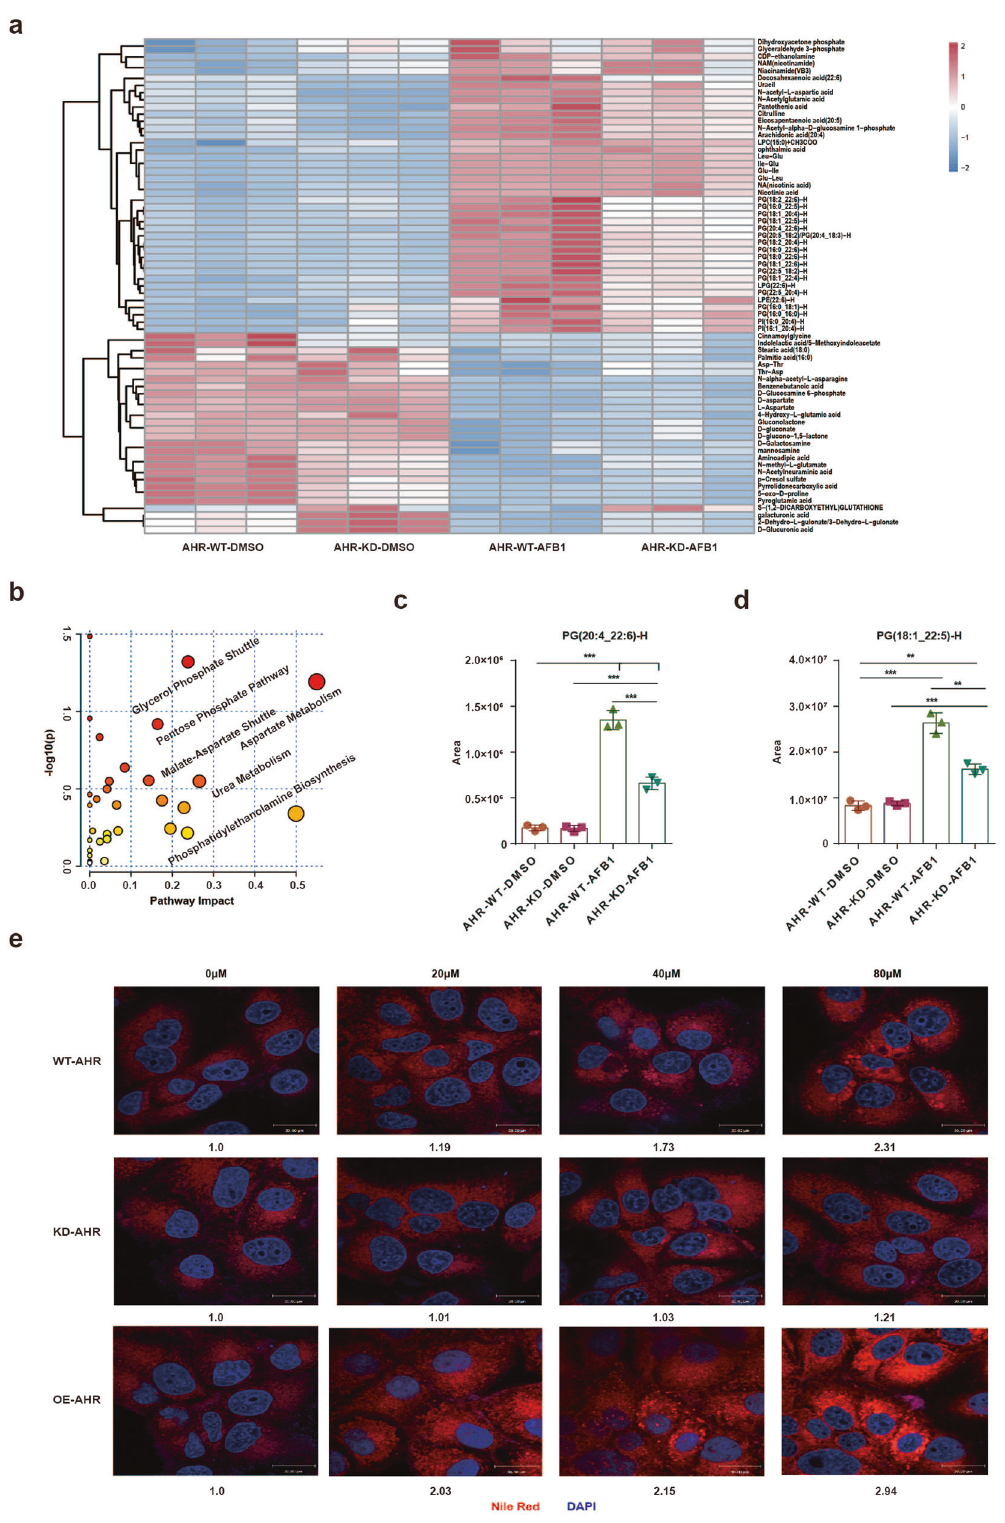
Fig. 3 AFB1 increases the accumulation of long chain fatty acids. a The heatmap of regulated metabolites extracted from the AHR -WT-DMSO, AHR -KD-DMSO, AHR -WT-AFB1, and AHR -KD-AFB1 group in the negative ion mode. b Pathway enrichment analysis of regulated metabolites of the four groups in the negative ion mode. c , d The level of c PG(20:4_22:6)-H and d PG(18:1_22:5)-H was detected by LC – MS/MS. The results were expressed as mean ± SD. Data among multiple groups were analyzed using two-way ANOVA, * p < 0.05, ** p < 0.01, and *** p < 0.001. e Representative fl uorescence images of cells stained with Nile Red to detect LCFAs (600X). Nuclei are stained with DAPI